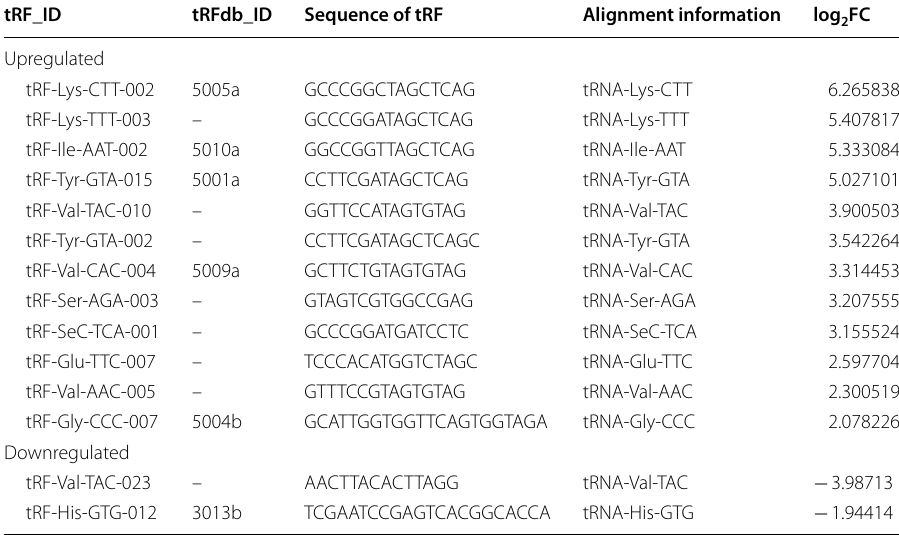
Table 1 Differentially expressed tRFs in